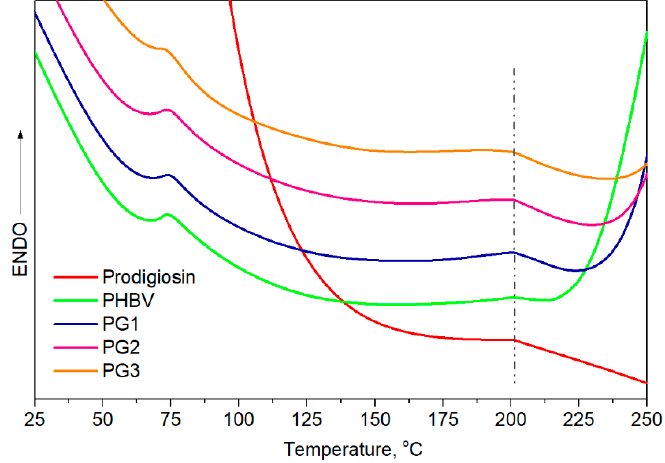
Figure 4. DSC curves of prodigiosin, pure PHBV and biopolymer films with incorporated PG (PG1–PG3).